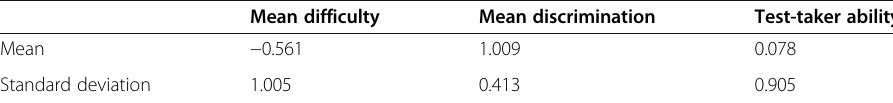
Table 4 Learner response data analysis by IRT